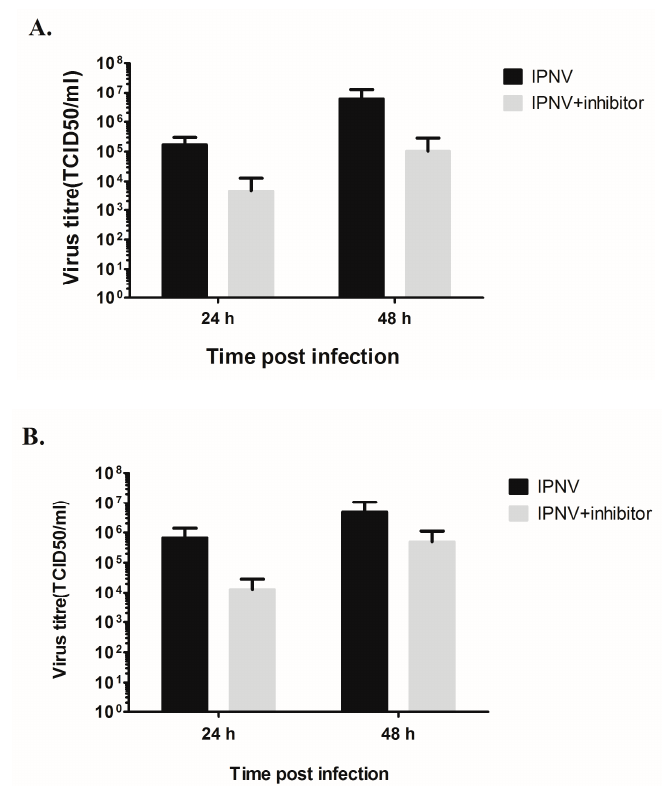
Figure 7. Effect of the PKR inhibitor C16 on the intracellular virus loads. CHSE-214 ( A ) and TO ( B ) cells were either treated with 2 µM of the PKR inhibitor C16 or left untreated and then infected with IPNV at 20 PFU/mL. The virus was released from attached cells by 2 rounds of freeze-thaw at different time post infection followed by titration in CHSE-214. Data represent an average of six parallels taken from two independent infections ± SD.